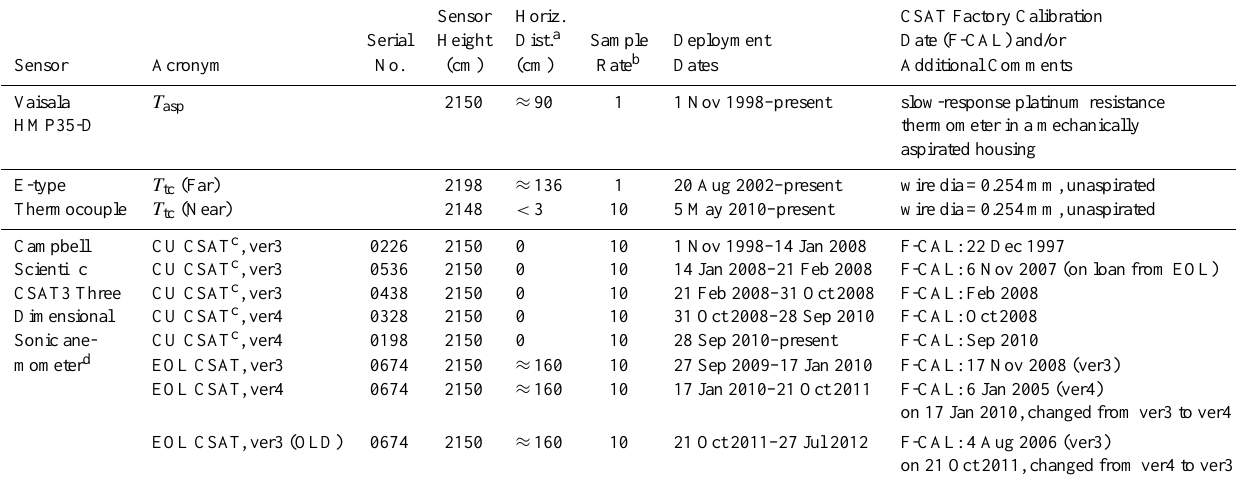
Table 1. A summary of NWT AmeriFlux tower temperature measurements used in our study. Sensor Horiz.